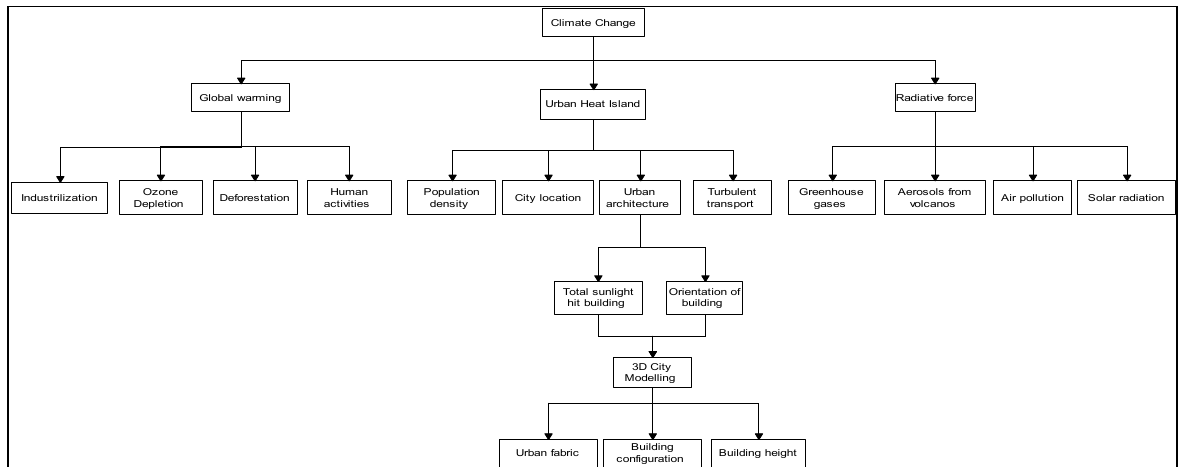
Figure 1. Connection between UHI and urban building